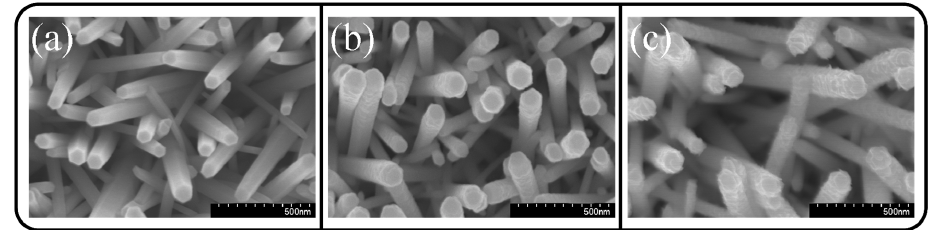
Figure 1. ( a ) SEM micrograph of ZnO-CdS (5 nm) nanorods; ( b ) SEM micrograph of ZnO-CdS (20 nm) nanorods; ( c ) SEM micrograph of ZnO-CdS nanorods